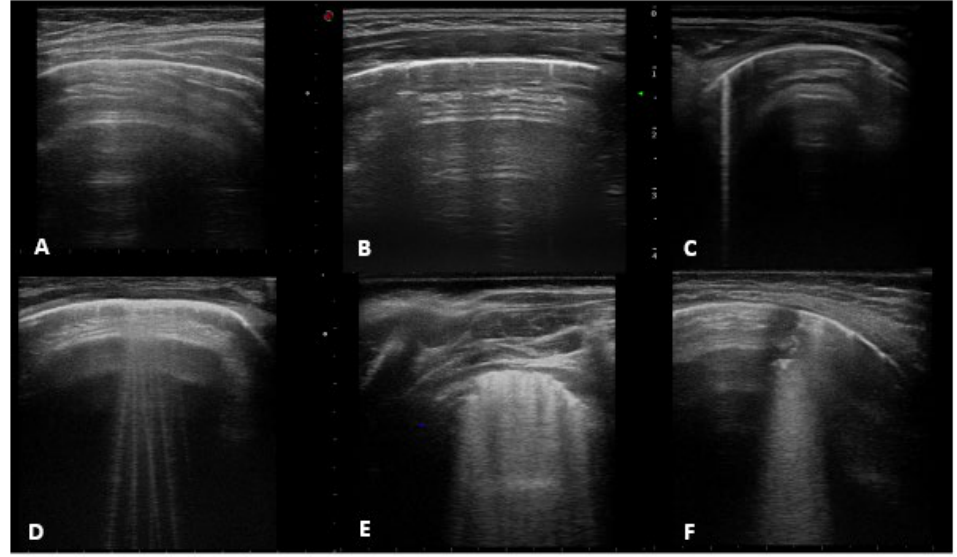
Figure 1. LUS findings. ( A ) A-lines, normal ultrasound; ( B ) short vertical artifact; ( C ) isolated-B line; ( D ) multiple B lines; ( E ) white lung; ( F ) subpleural consolidation.